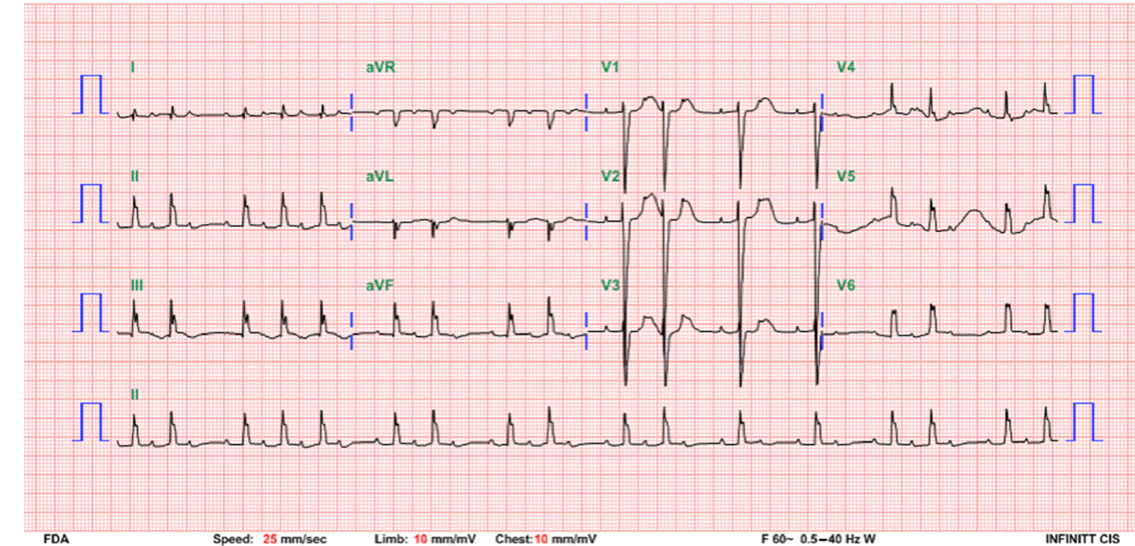
Figure 2. ECG at 3 days of age indicating a Mobitz type I second-degree AV block with an atrial rate of 144 bpm and a ventricular rate of 60–90 bpm.